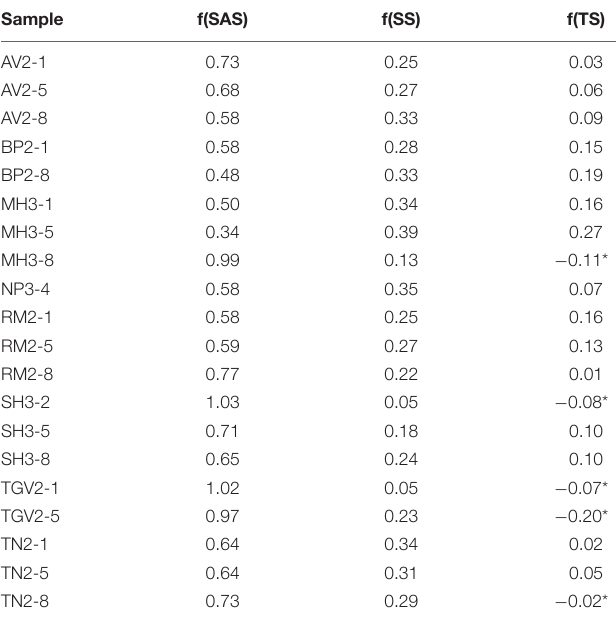
TABLE 6 | Three-component mixing model to determine relative contributions of different sources of SO 42 − .